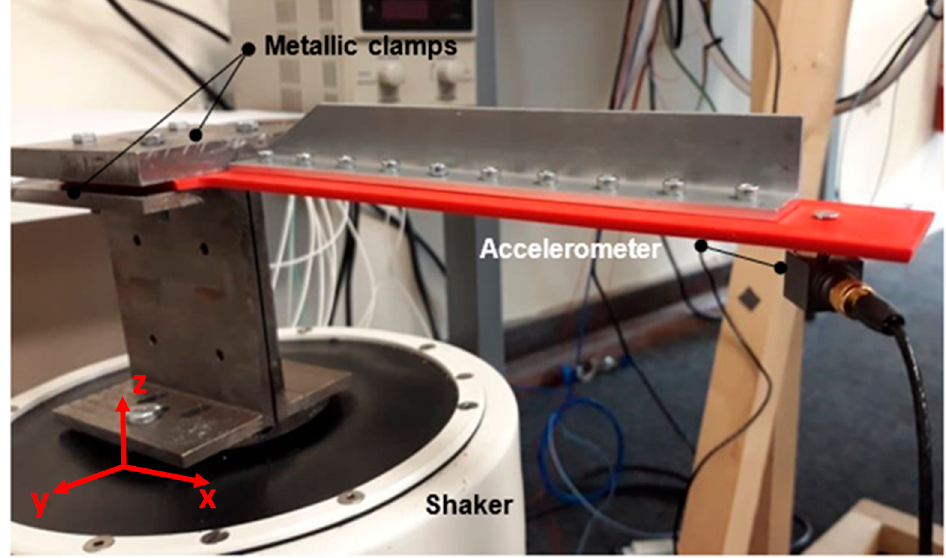
Figure 3. Clamping con fi guration of the sample.